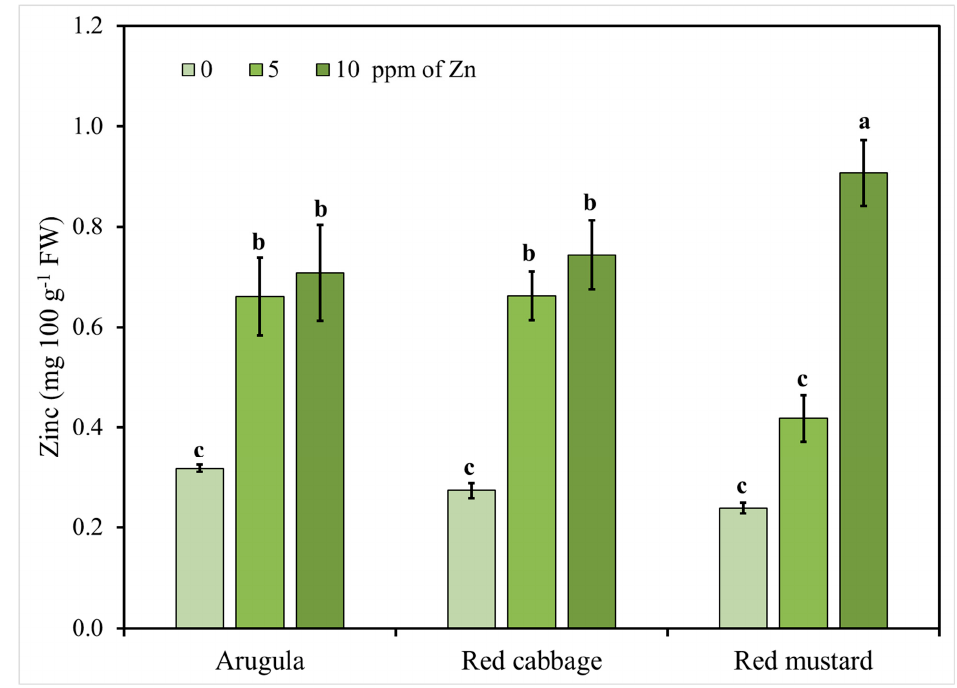
Figure 2. Arugula, red cabbage, and red mustard microgreens zinc (Zn) concentration in response to nutrient solution Zn level (0, 5, 10 mg L − 1 ). Vertical bars represent the mean ± SE of three replications. Different letters indicate means that are significantly different ( p < 0.05) using Student-Newman-Keuls multiple range test.